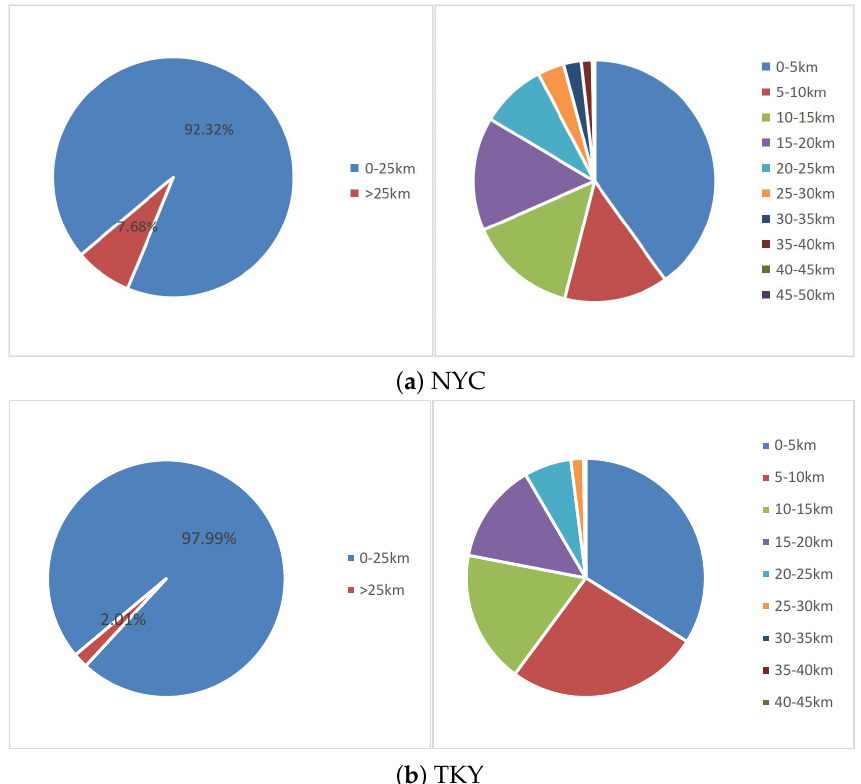
Figure 2. The distance distribution between two adjacent POIs of the trajectories in the two datasets of NYC and